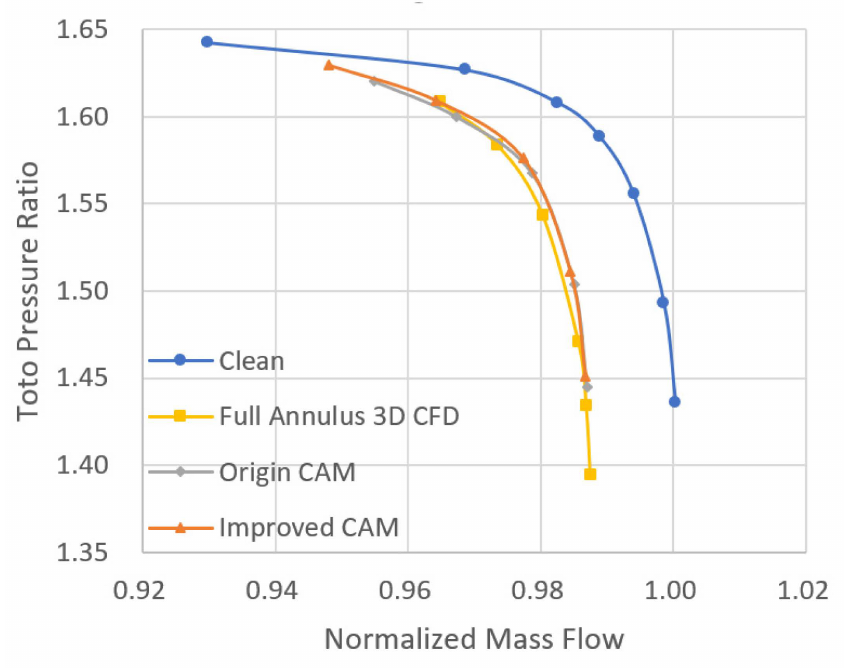
Figure 15. Total pressure ratio versus mass flow rate under distortion at 100% revolution